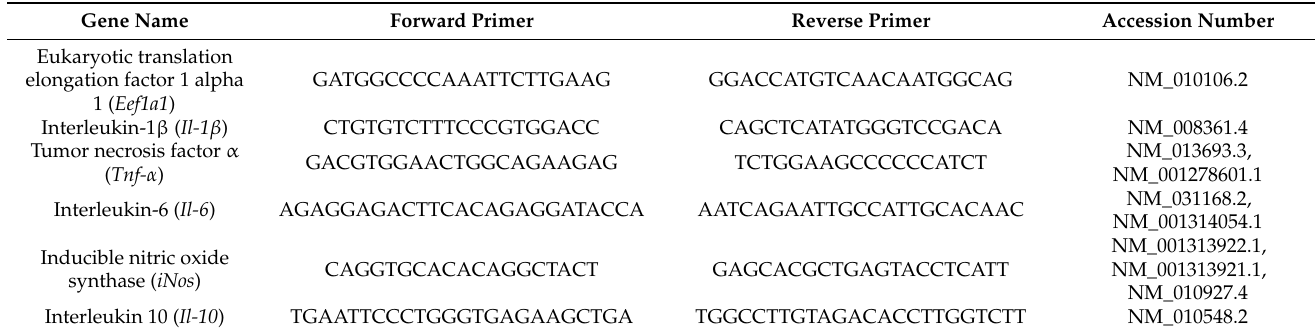
Table 1. List of genes and their primer